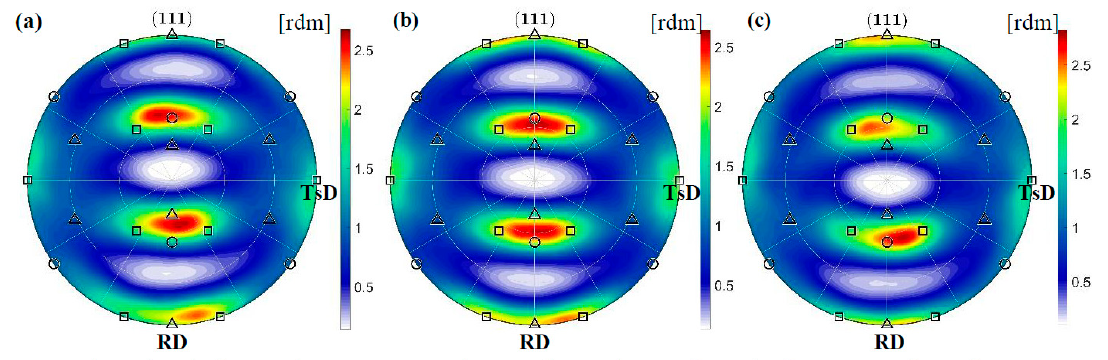
Figure 8. {1 1 1} pole figures for austenite in the area located 2 mm from the fracture surface of specimens stretched at the temperature of 4.2 K ( a ), 77 K ( b ) and RT ( c ). The Brass, Goss and Cu texture components are denoted by squares, circles and triangles, respectively.